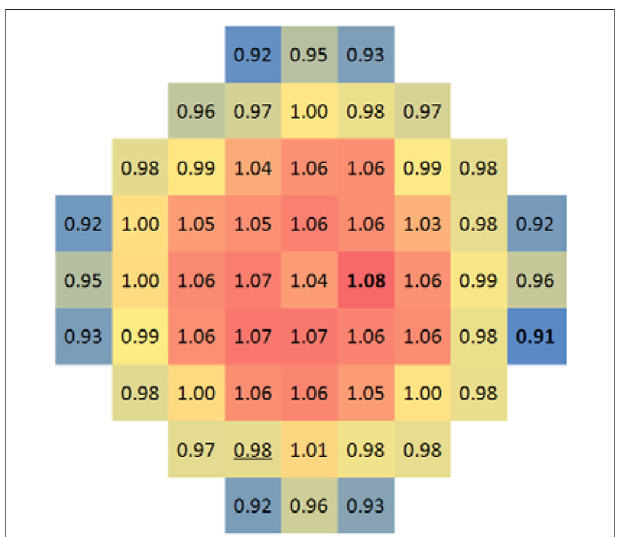
FIGURE 11 | Flow distribution map under twisted